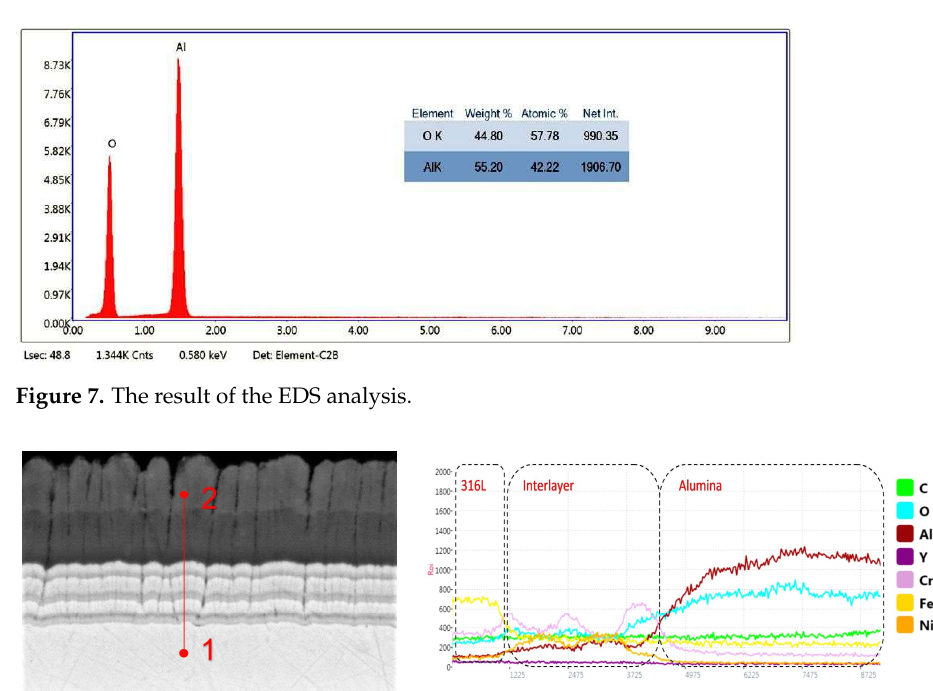
Figure 7. The result of the EDS analysis.